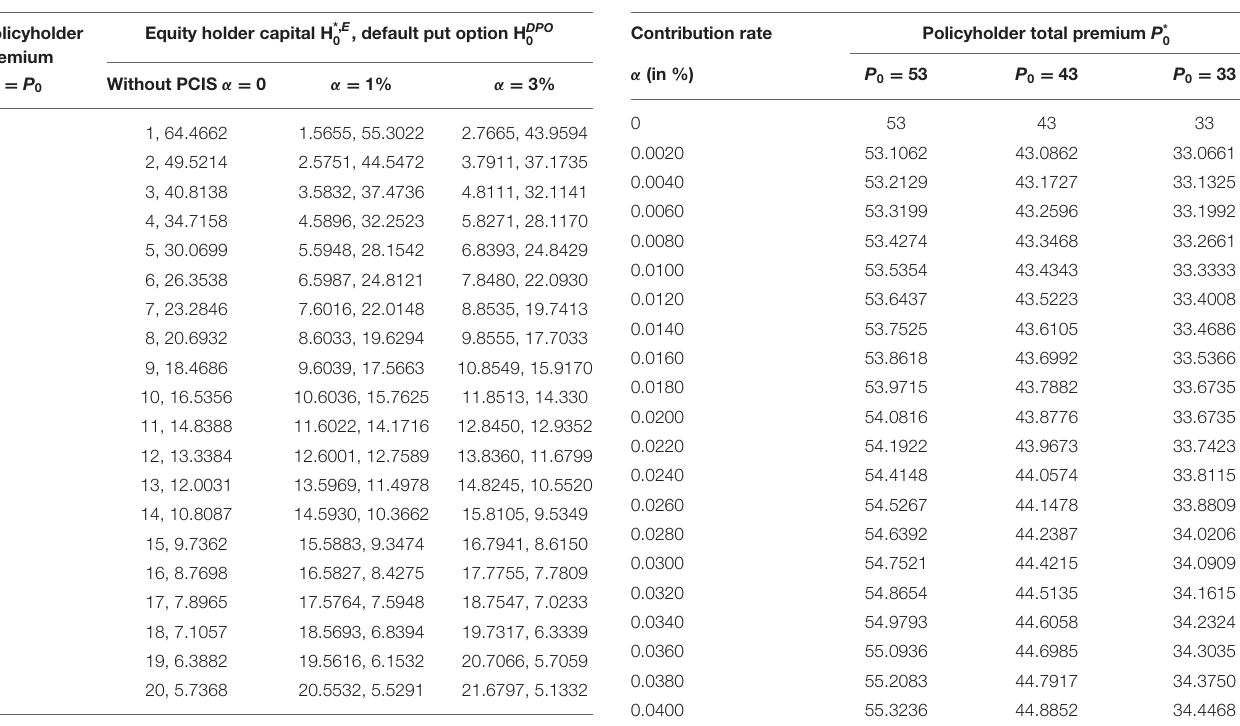
TABLE 6 | Policyholder total premium p ∗ 0 for different contribution rates α and initial premium p 0 in policyholder paying